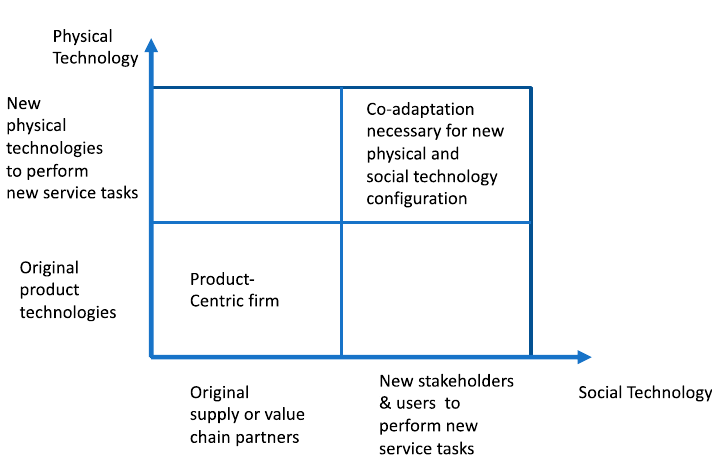
Figure 3. Conceptualization transition from product to service: a social technology and physical technology approach [16].